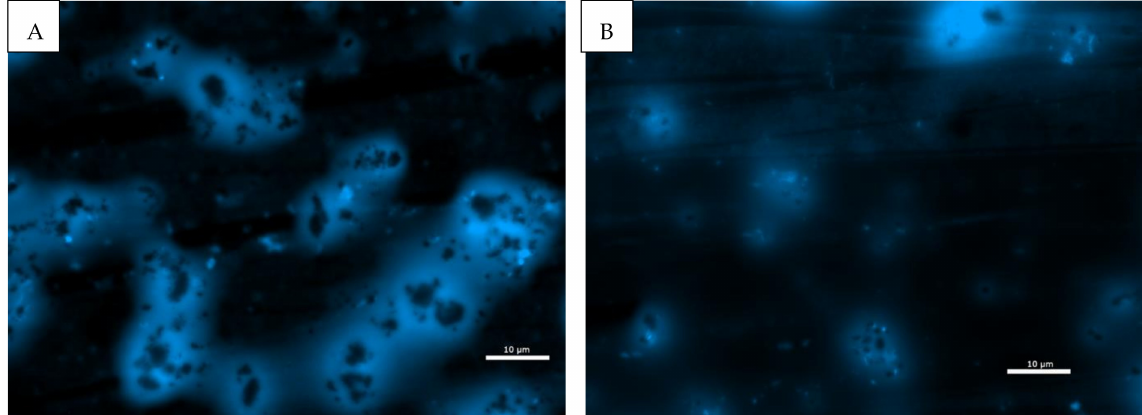
Figure 6. Epifluorescence image of DAPI (4 (cid:48) ,6-diamidino-2-phenylindole) stained ( A ) Zn RZ Tail June sample and ( B ) Cu Rougher Feed November sample. Cells appear as bright blue spots and residual stain as paler blue, especially around the black mineral particles. The scale bar indicates 10 µ